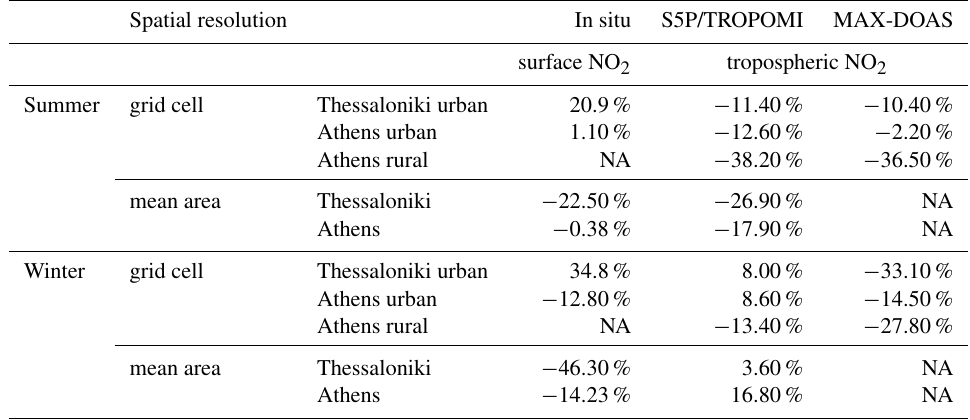
Table 6. Relative summer and wintertime biases between LOTOS-EUROS simulations of tropospheric of NO 2 levels and S5P/TROPOMI (first column) and MAX-DOAS (second column) as well as of NO 2 surface simulations and in situ measurements (third column). The “grid cell” spatial resolution refers to biases of NO 2 values found at the same grid cell, while “mean area” refers to the biases calculated for the total area depicted in Fig. 10, middle and lower